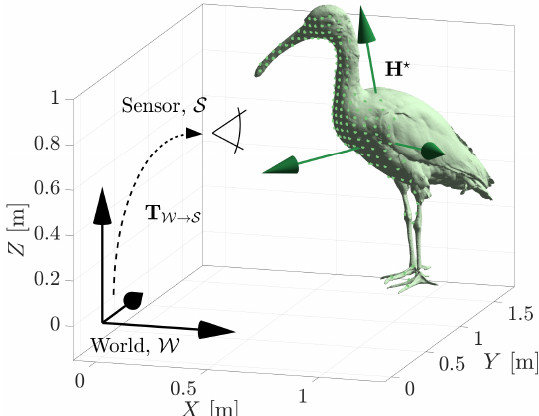
Figure 13. The maximum sum of evidence estimate, H (cid:63) , of a 3D shape’s pose.